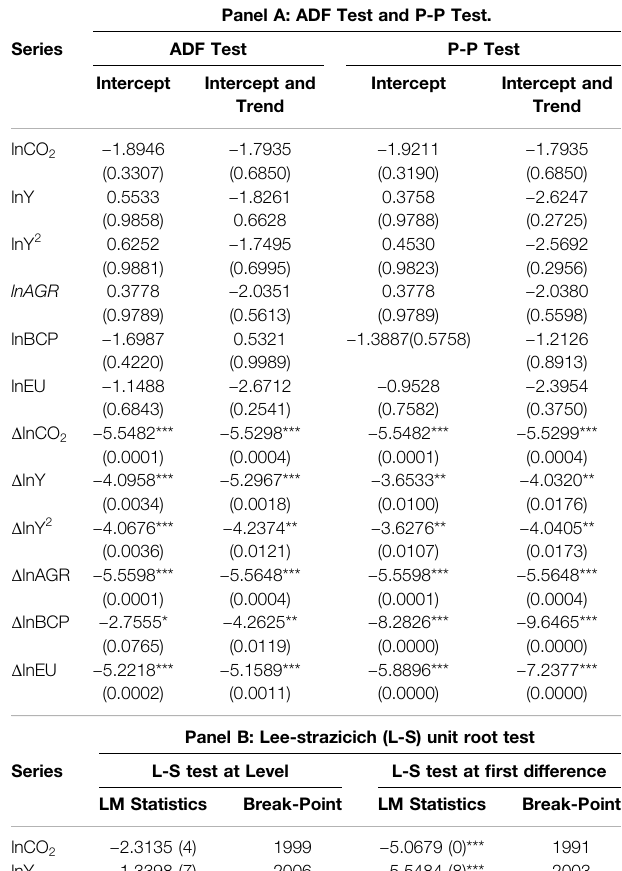
TABLE 2 | Augmented Dickey-Fuller (ADF), Phillips-Perron (P-P) and Lee- Strazicich (L-S) Unit Root tests. Panel A: ADF Test and P-P Test.